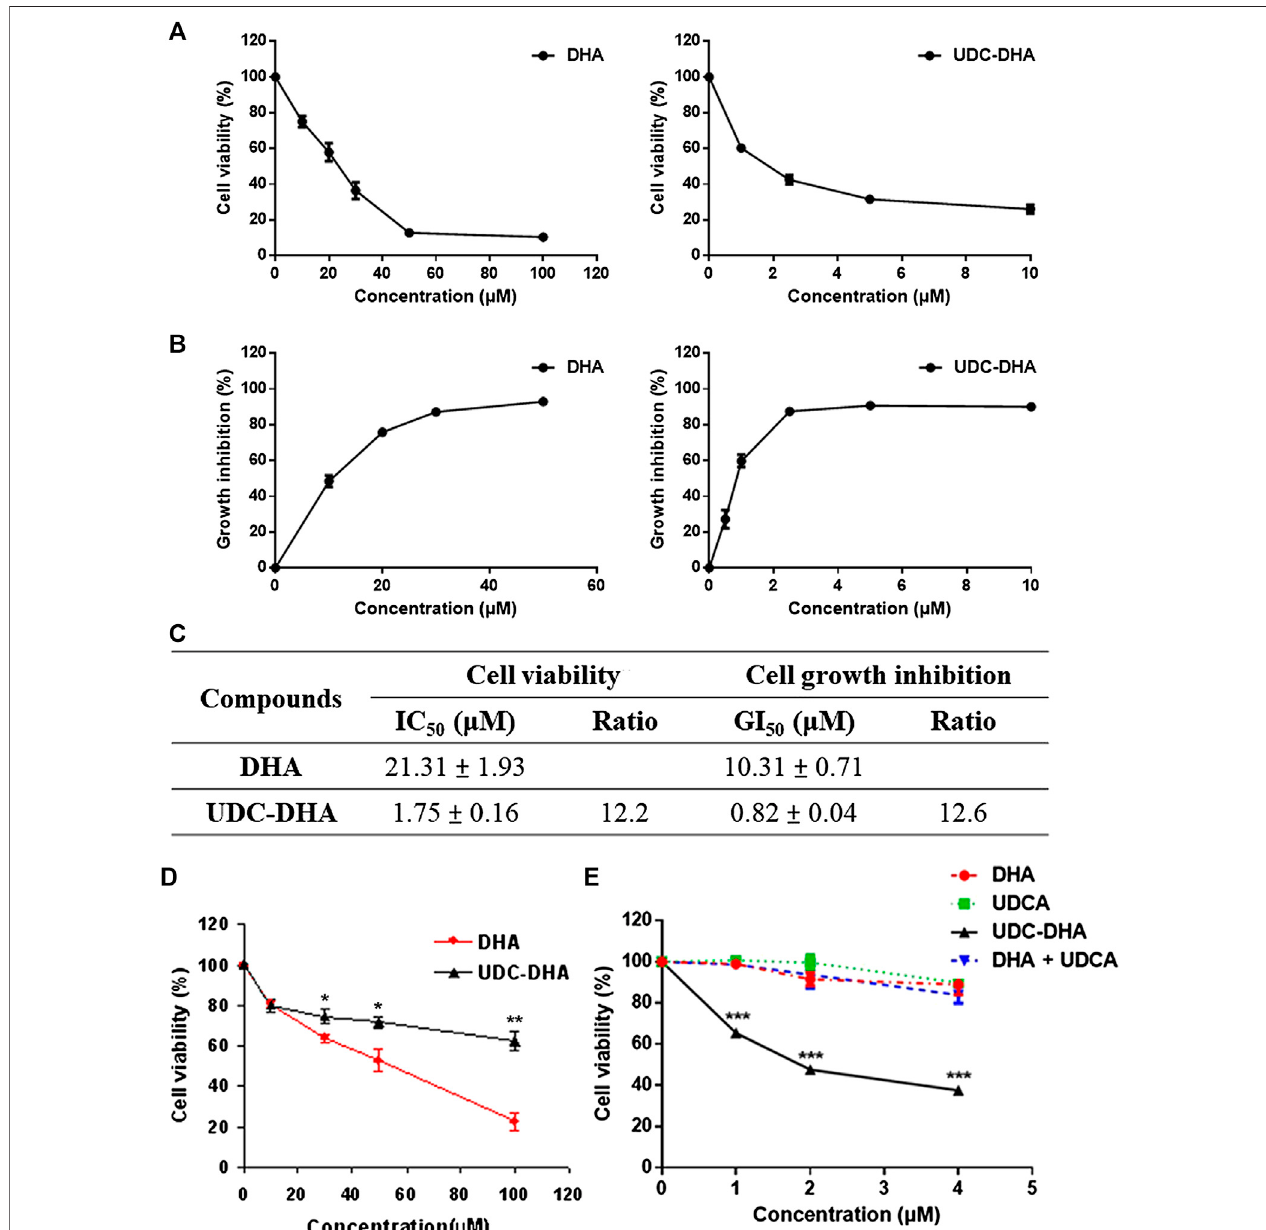
FIGURE2| ThegrowthinhibitoryeffectofDHAandUDC-DHAinHepG2cellsaswellasinnormalhuman fi broblasts. (A) Dose-responsecurvesdeterminedby the MTT assay in HepG2 cells. (B) Dose-response curves determined by the SRB assay in HepG2 cells. (C) IC 50 or GI 50 and the ratio of IC 50 or GI 50 (DHA/UDC- DHA) obtained from MTT and SRB assays. HepG2 cells were treated with indicated concentrations of DHA or UDC-DHA for 72 h, followed by the MTT or SRB assay. Data are presented as mean ± SEM of at least three independent experiments. (D) The dose-response curves of DHA and UDC-DHA in normal human fi broblasts. Normal human dermal fi broblasts were treated with indicated concentrations of DHA or UDC-DHA for 72 h, followed by the MTT assay. Data are presented as mean ± SEM of at least three independent experiments. Statistical signi fi cance (DHA vs. UDC-DHA) was evaluated by two-tailed Student ’ s t -test. *, p < 0.05; **, p < 0.01. (E) The dose-response curves of DHA, UDCA, UDC-DHA, and the combination of DHA and UDCA in HepG2 cells. HepG2 cells were treated with indicated concentrations of DHA or UDCA alone or in combination, or treated with UDC-DHA for 72 h, followed by the MTT assay. Data are presented as mean ± SEM of at least three independent experiments. Statistical signi fi cance (UDC-DHA vs. DHA, UDCA or DHA + UDCA) was evaluated by two-tailed Student ’ s t -test. ***, p < 0.001.